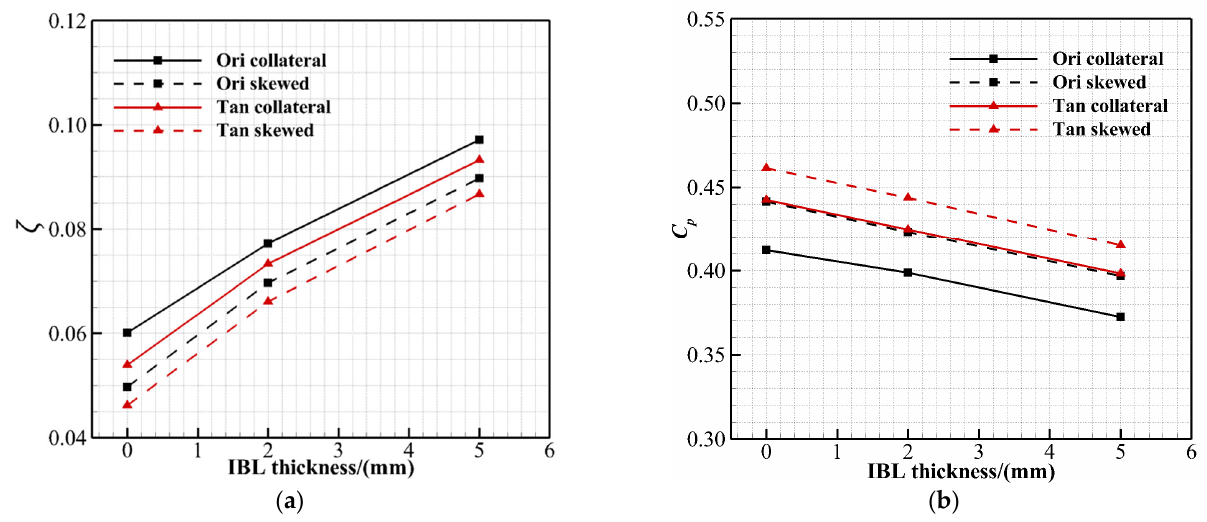
Figure 8. The variation of the overall outlet parameters with the IBL thickness for the original cascade and tandem cascade under different IBL conditions (collateral and skewed) at the design incidence angle: ( a ) Total pressure loss coefficient; ( b ) Static pressure rise coefficient. Table 3. The total pressure loss coefficient difference between the tandem cascade and the original cascade. IBL Thickness